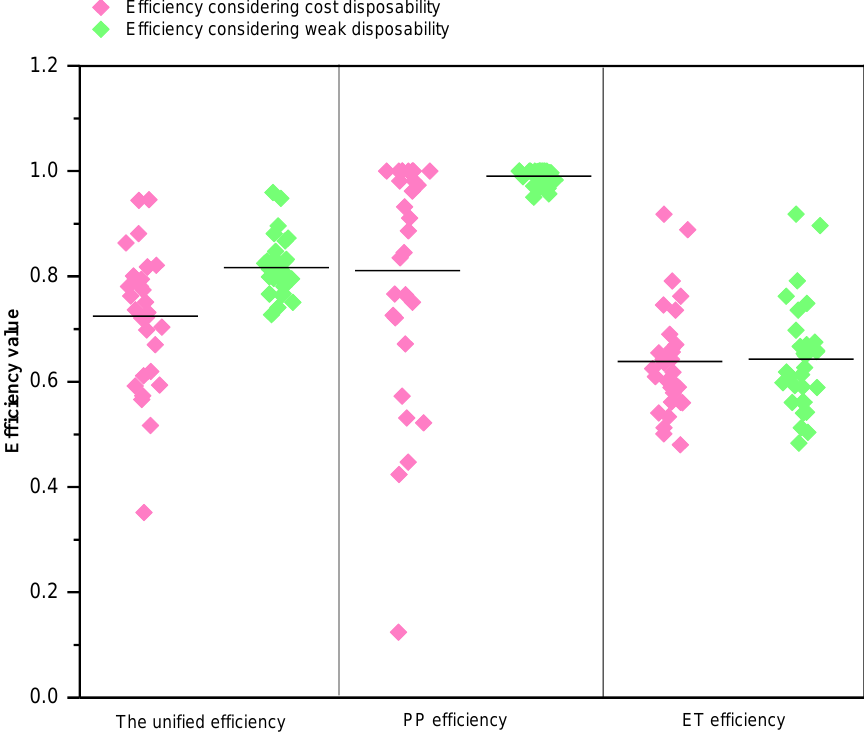
Figure 11. The efficiency comparison of different models. Figure 11. The e ffi ciency comparison of di ff erent